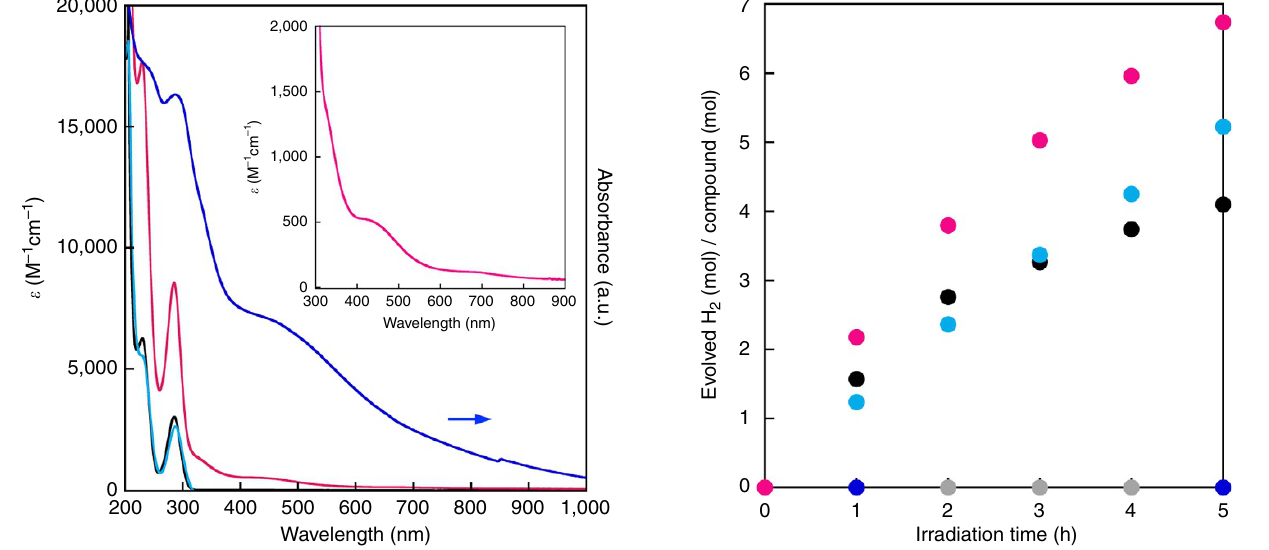
Supplementary Table 4. The structure of 1 is characterized by a pseudo-octahedral coordination geometry of the Fe atom,